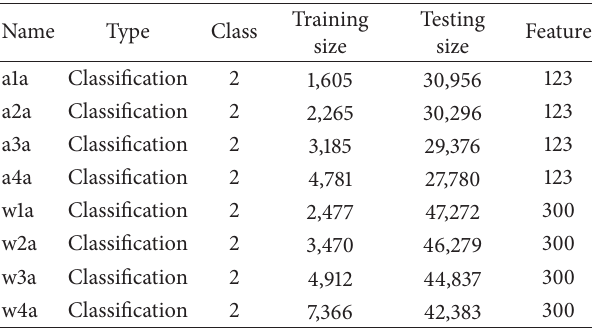
Table 1: Standard dataset for